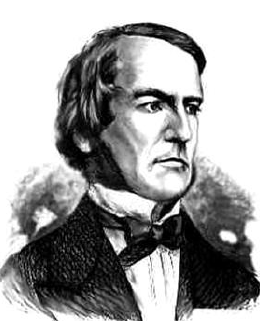
Fig. 1. Picture reprinted from MacTutor History of Mathematics: http: //www-groups.dcs.st-andrews.ac.uk/~history/Mathematicians/